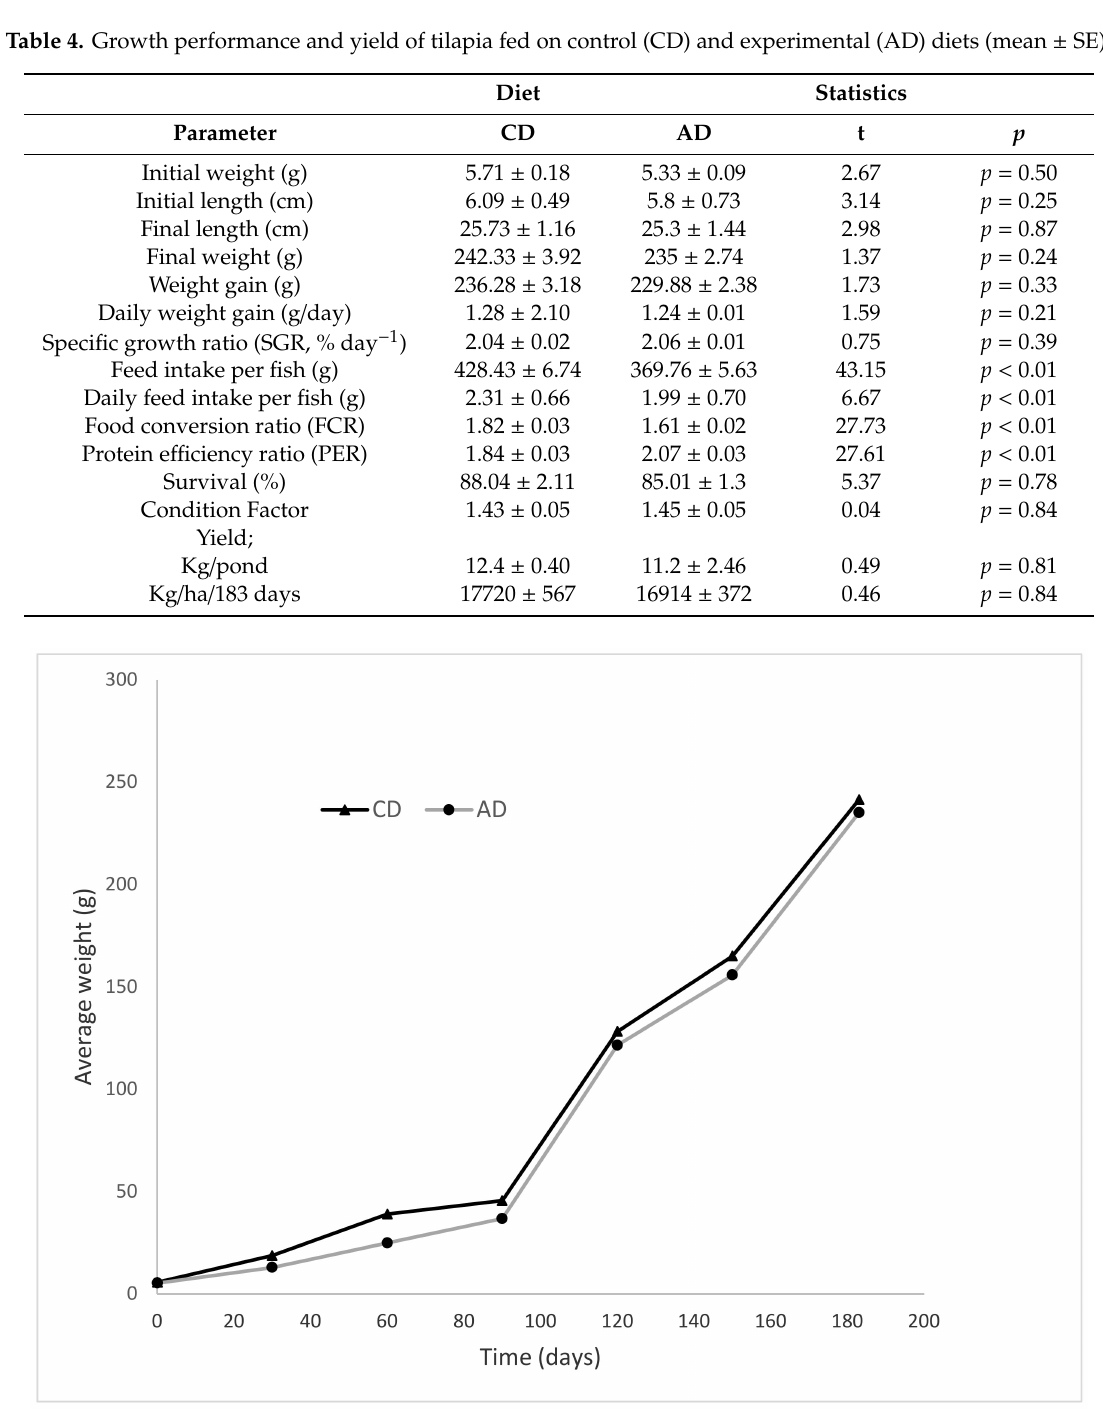
Figure 1. Growth curve for Oreochromis niloticus under di ff erent dietary treatments (AD, formulation with AW inclusion fed to fish for the first 100 days; CD, control diet without AW